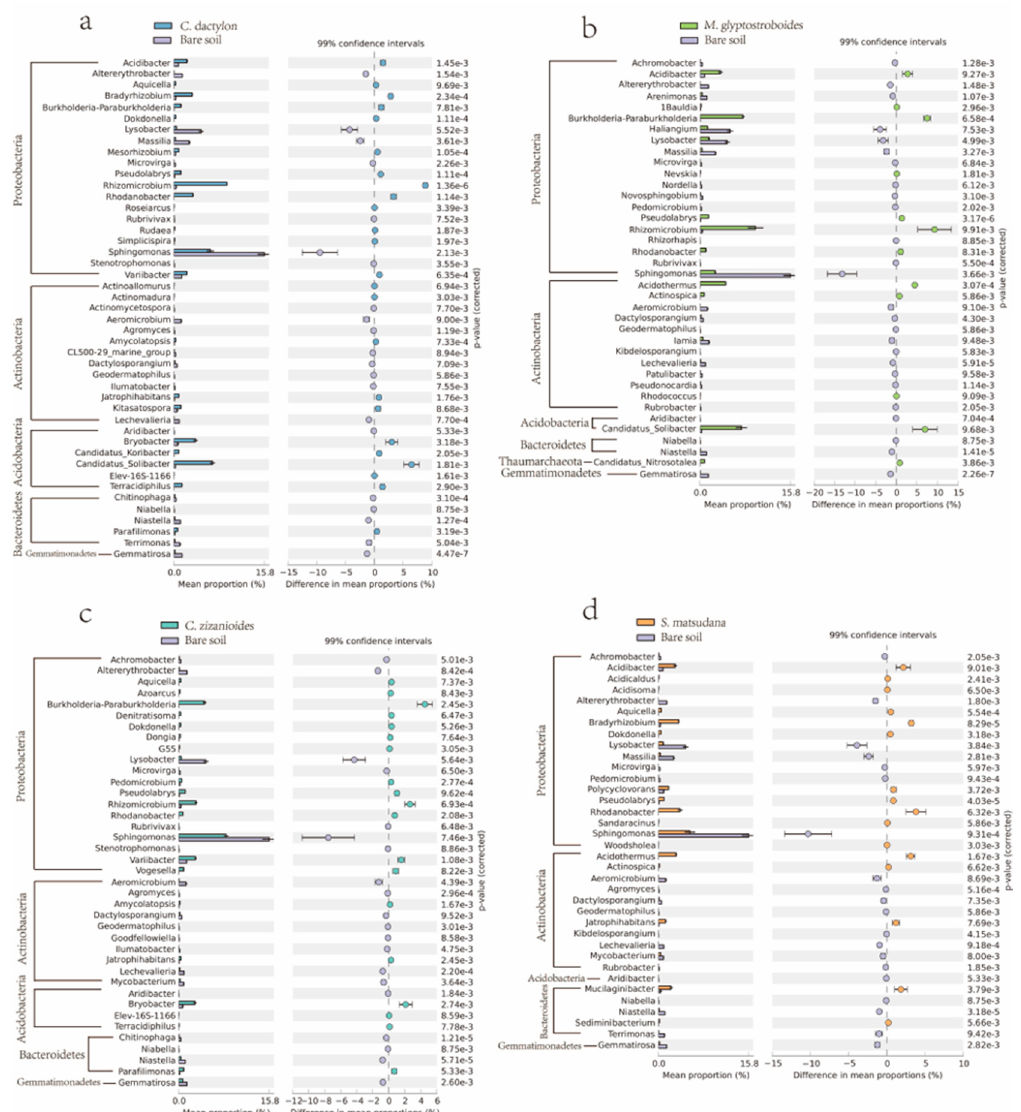
Figure 7. Extended error bar plots showing statistically significant differences in the bacterial community composition at the genus levels between different planted soils ( a : C. dactylon , b : M. glyptostroboides , c : C. zizanioides and d : S. matsudana ) and the bare control. Error bars indicate within-group standard deviations. Presented categories passed a corrected p value of <0.01 in Welch’s t test.